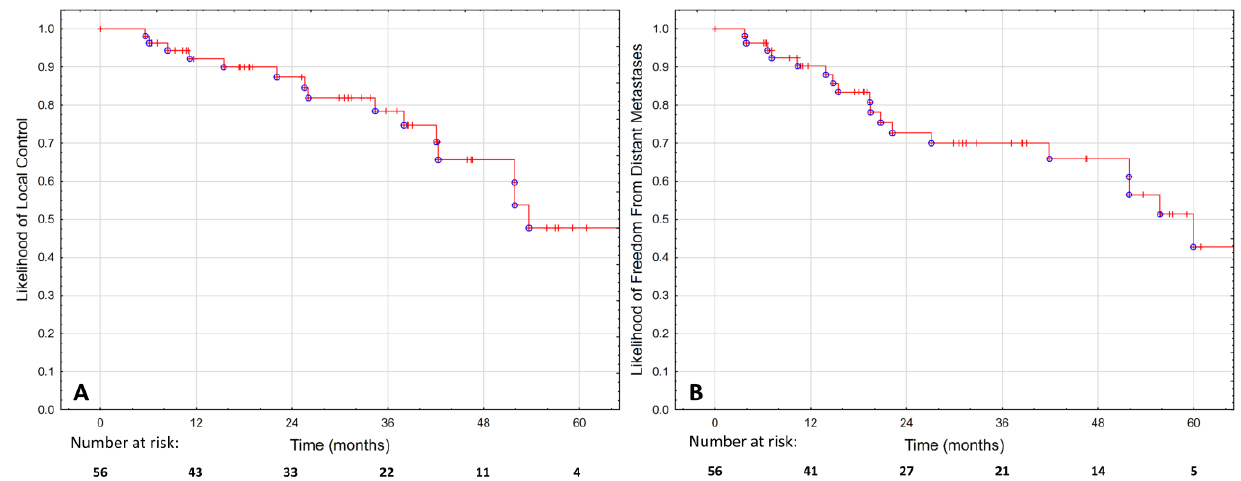
Figure 2. Local control ( A ) and freedom from distant metastases ( B ) in 56 patients treated with hypofractionated salvage re-irradiation for local post-radiotherapy prostate cancer recurrence. The local recurrence was predicted by parameters related to the initial radiotherapy.